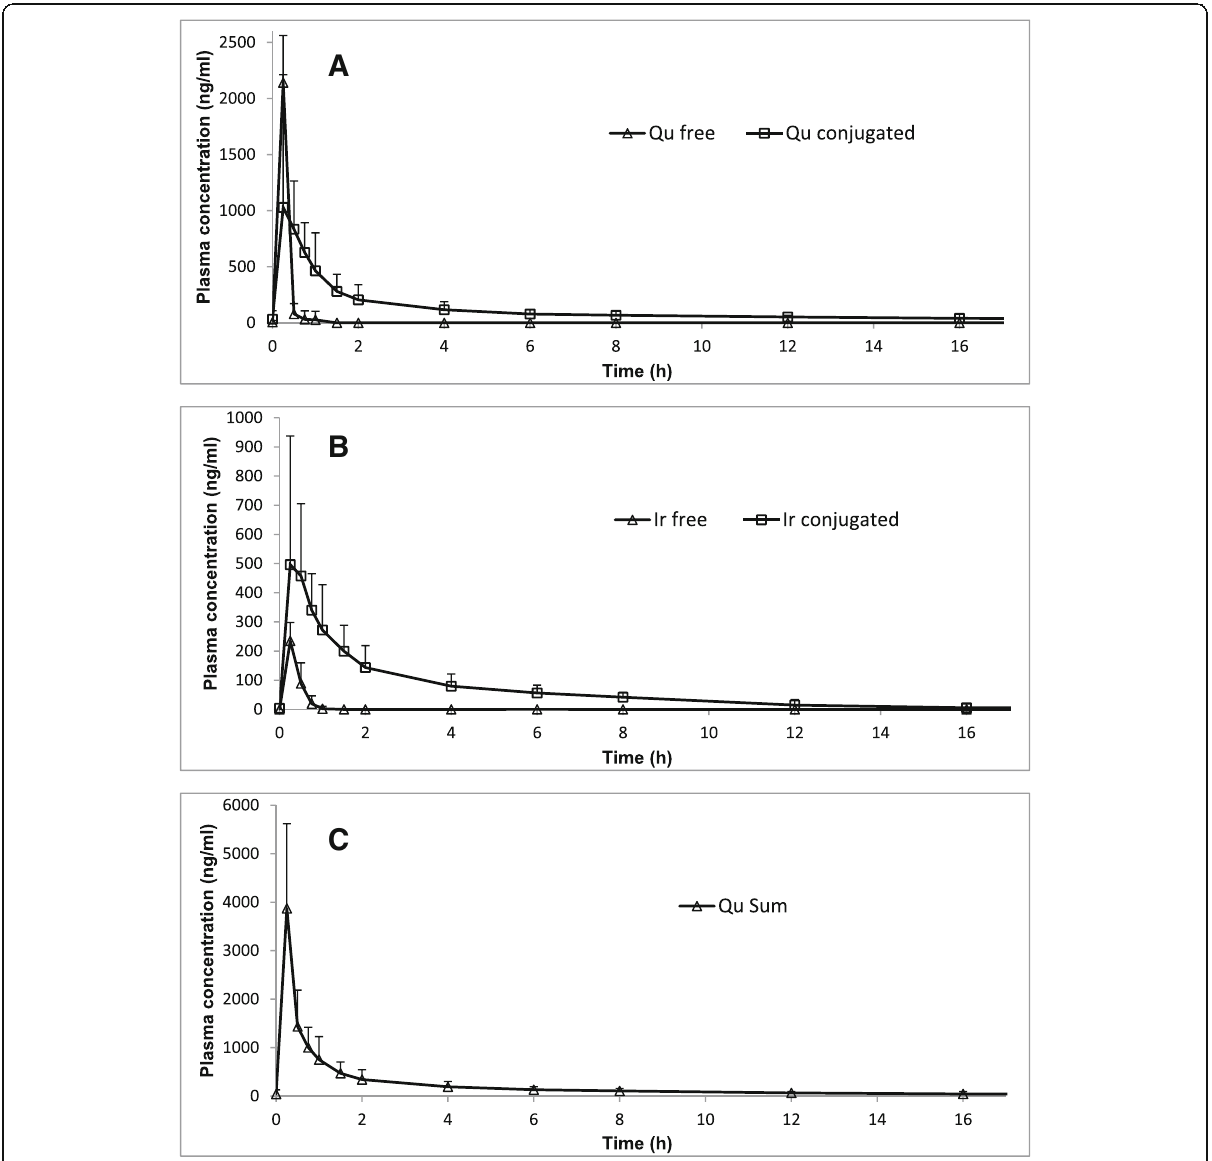
Fig. 4 Mean plasma concentration - time profile following intravenous administration of 250 mg/m 2 of human body surface area. a - free Qu and conjugated metabolites of Qu, b - free Ir and conjugated metabolites of Ir, c – sum of free and conjugated metabolites of Qu and Ir (+